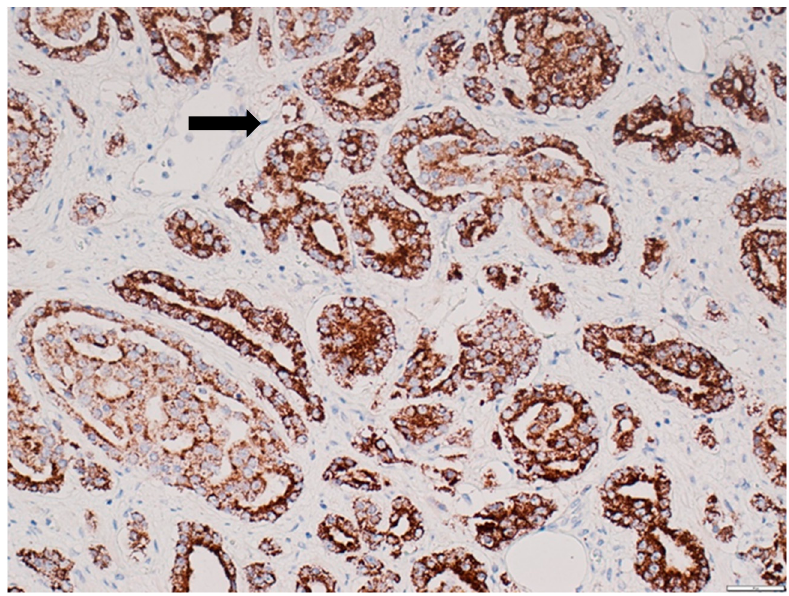
Figure 6. MSH-2 expression in prostate acinar adenocarcinoma. The black arrow indicates immuno- positive cells. Immunohistochemical staining method; magnification ×200; scale bar 100 µm. MMR expression was absent in 10 patients (10.86%) of 92 PCa patients (2 patients with grade group II, 5 patients with grade group IV, and 3 patients with grade group V).